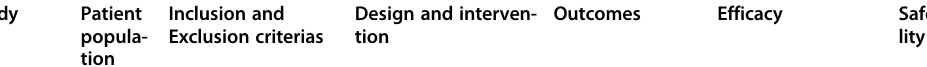
Table 4 Clinical trials of the traditional plants used for skin problems in Turkey (Continued) Study Patient